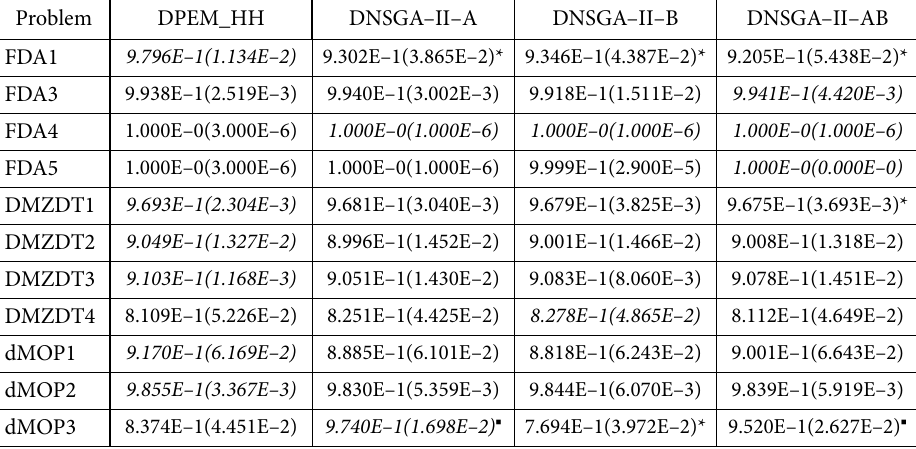
Table 3. Offline mean and standard deviation of MS metric for DPEM_HH and all DNSGA–II versions